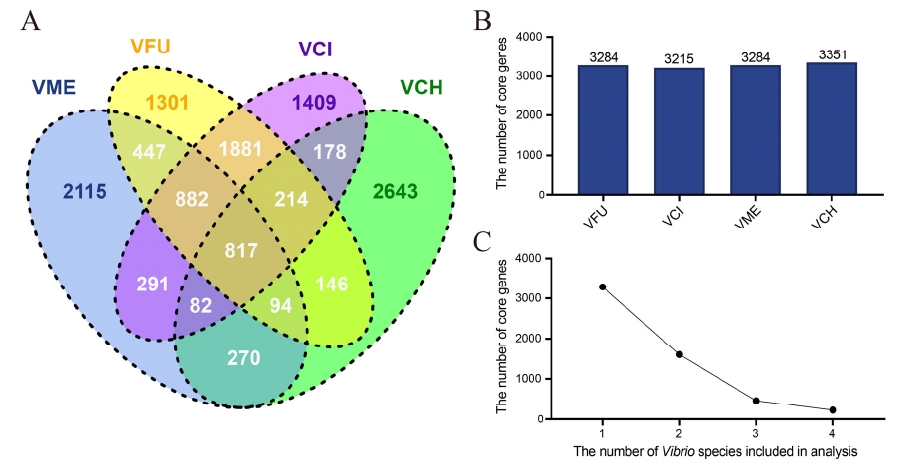
Figure 2. Comparative genomic analysis of Vibrio fujianensis and three other Vibrio species. ( A ) Venn diagram of the shared and unique genes found in V. fujianensis FJ201301 T and three other Vibrio